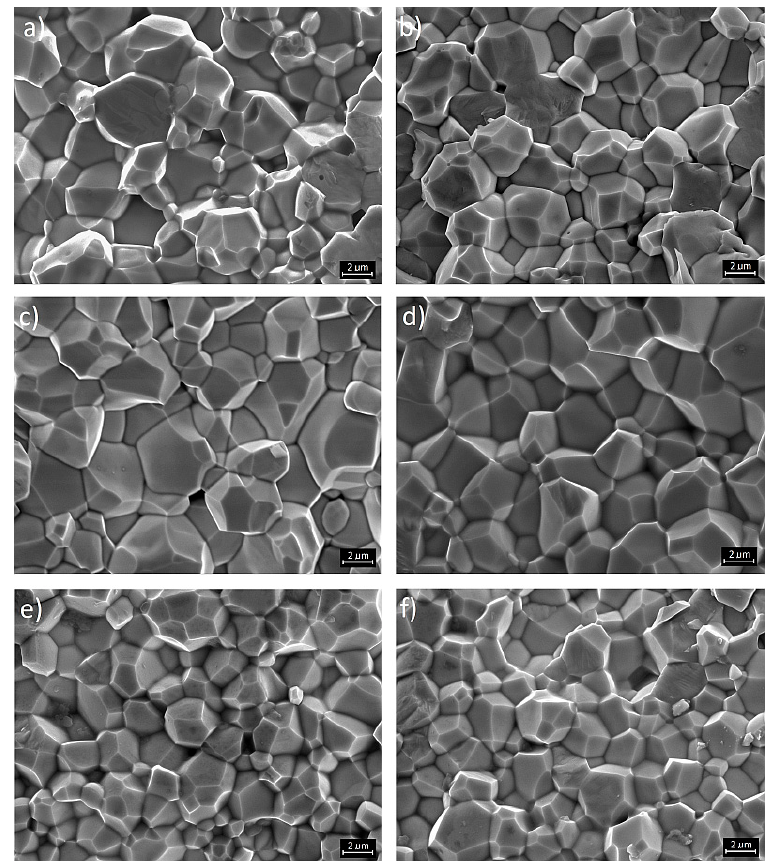
Figure 2. SEM images of PMN–PT–PS solid solutions: ( a ) PPP0.25; ( b ) PPP0.28; ( c ) PPP0.31; ( d ) PPP0.34; ( e ) PPP0.37; and ( f ) PPP0.40.